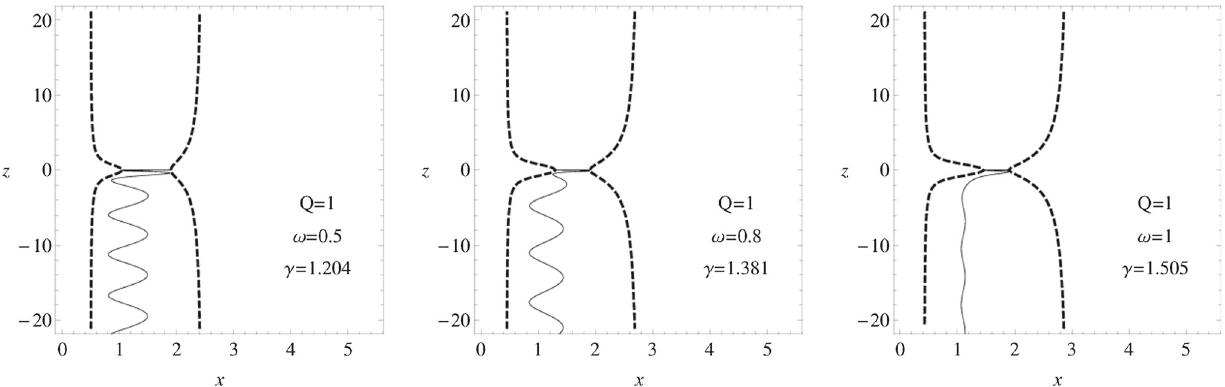
Fig. 11 Escaping trajectories of string in flat spacetime with respect to string charge parameter ω . Asymptotical Lorenz factor γ of transmit- ted string loops is given for three values of ω parameter for the value